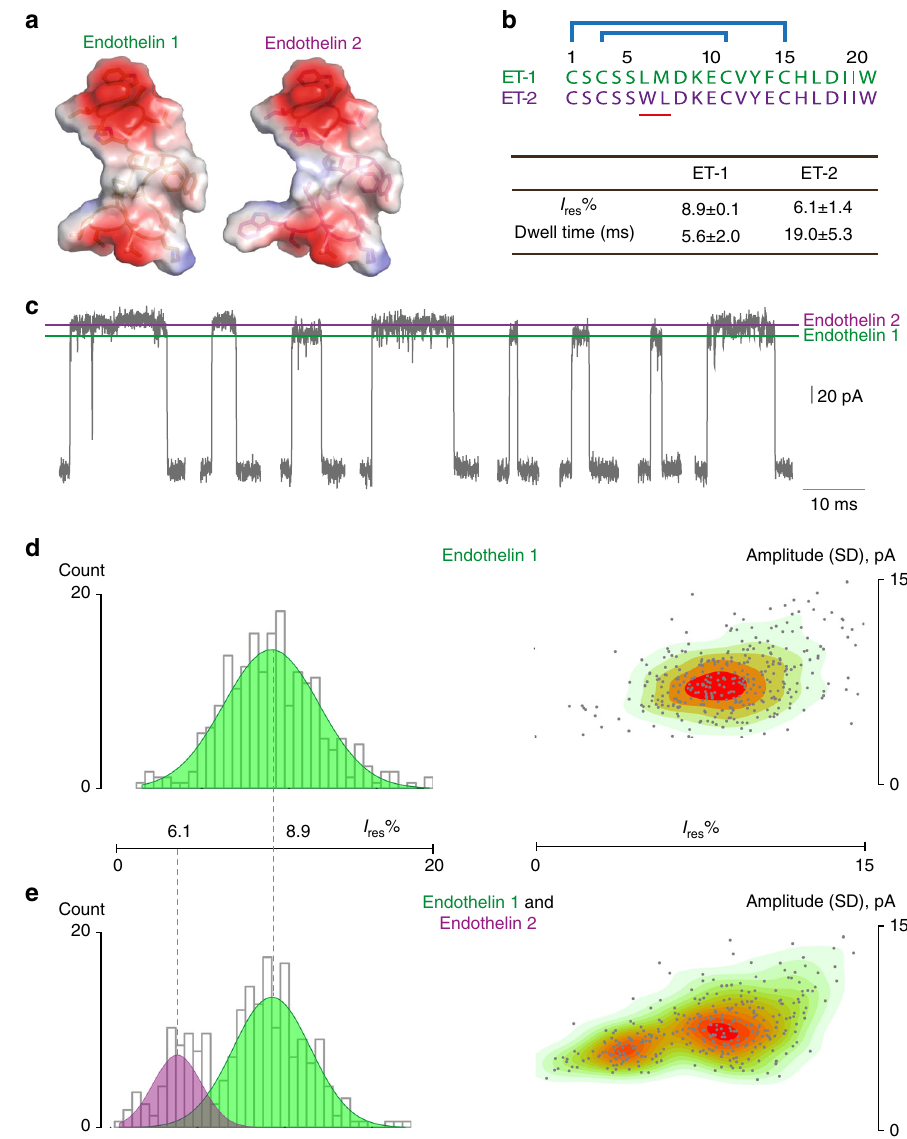
Fig. 5 Discrimination of endothelin 1 and 2 with WtFraC at pH 4.5. a Molecular surface representation of endothelin 1 (PDB: 1EDN) and endothelin 2 (homology model from endothelin 1, PyMOL) using electrostatic coloring (PyMOL). b Above: amino-acid sequences of endothelin 1 and 2. Blue lines indicate the disul fi de bridges in each polypeptide. Below: I res% and dwell time for endothelin 1 and endothelin 2 blockades at − 50 mV in pH 4.5 buffer (1 M KCl, 0.1 M citric acid, 180 mM Tris base). Standard deviations are calculated from three experiments (Supplementary Fig. 16). c Representative endothelin 1 and endothelin 2 blockades to the same FraC nanopore under − 50 mV applied potential. d Histogram (left) of residual currents provoked by 2 µ M endothelin 1 and corresponding heatplot depicting the standard deviation of the current amplitude vs. I res% (right). e Same as in d but after addition of 8 µ